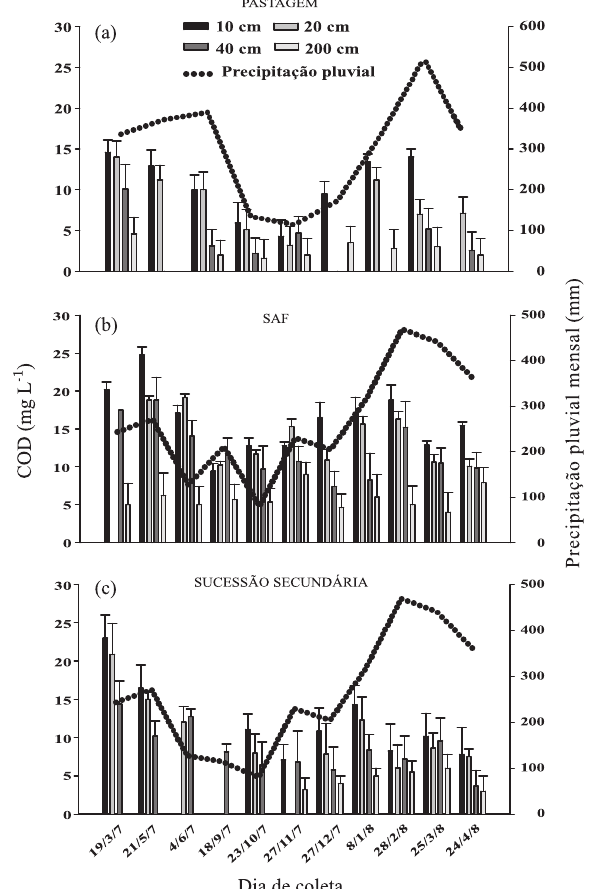
Figura 2. Variação do Cod em diferentes épocas e profundidades do solo em pastagem, saF e sucessão secundária. as barras representam as concentrações de Cod na solução do solo com os respectivos desvios-padrão; a linha pontilhada mostra a precipitação pluvial em cada período de